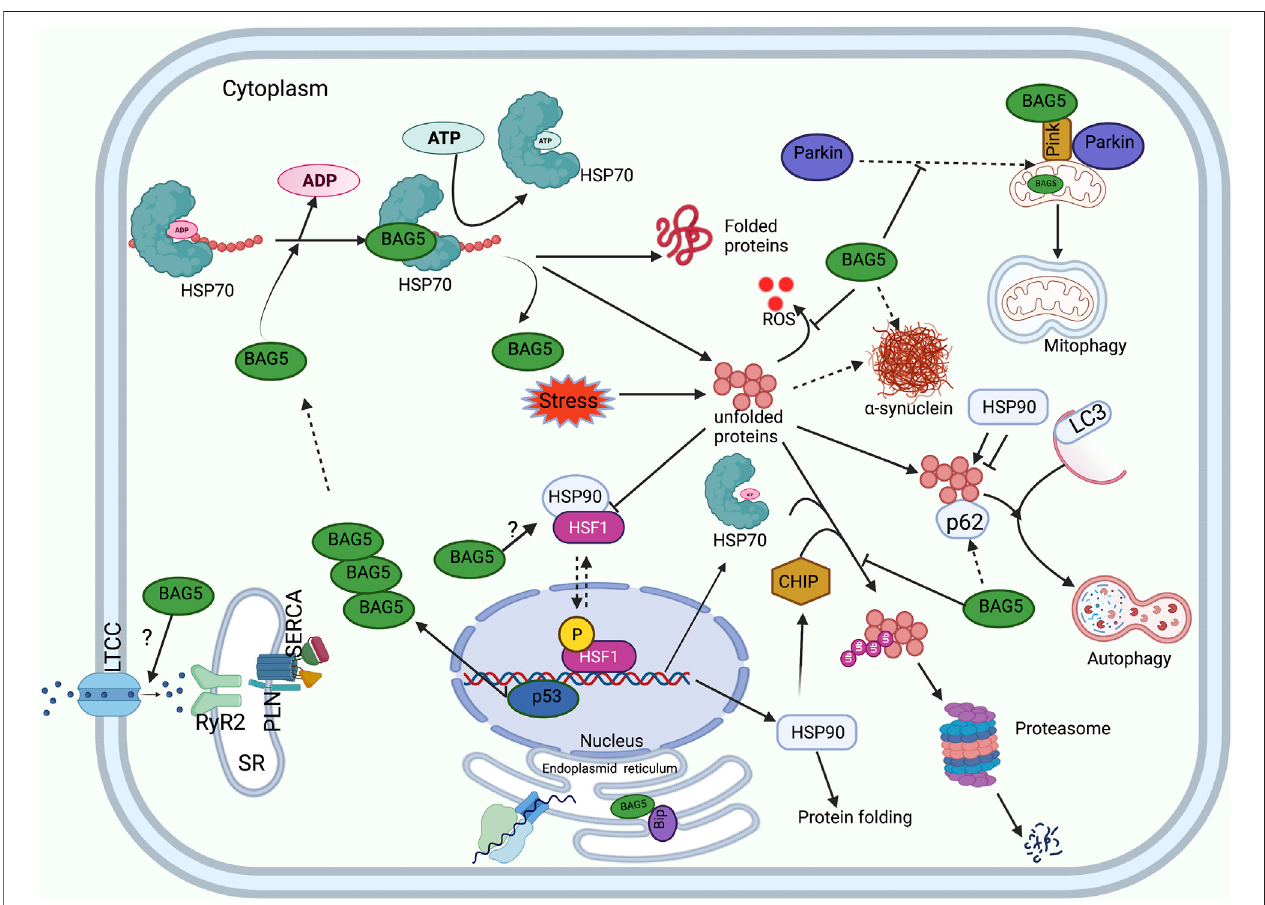
FIGURE 2 | Functions of BAG5 in cellular protein quality control. A diagram shows the involvement of BAG5 in the major cellular functions: regulation of HSP70 mediated protein folding, degradation of protein by autophagy and UPS system, regulation of PINK and Parkin mediated cellular mitophagy, regulation of cellular ER stress, generation of heat shock response, inhibition of ROS production, and handaling of Ca2+ ions. Sarcoplasmic reticulum (SR), L-type calcium channel (LTCC), Ryanodine receptor (RyR), Sarcoplasmic Ca2+ -ATPase (SERCA), Phospholamban (PLN).